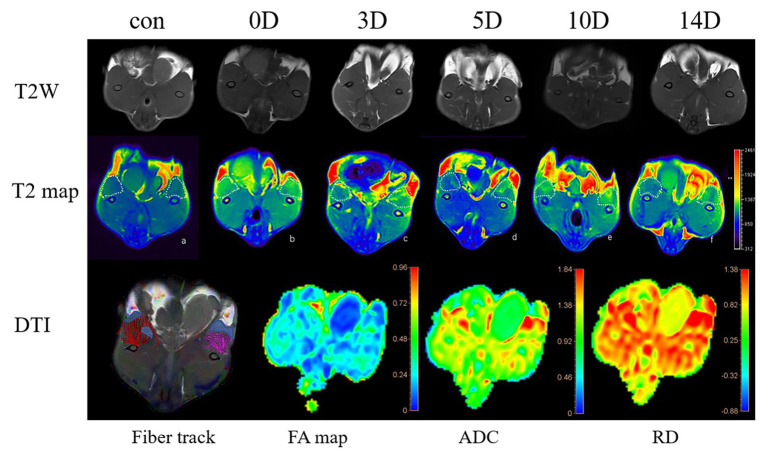
T2WI, T2map axial sequence images in the (a-f) control group and frostbite group (0, 3, 5, 10, 14 days). The muscles in the ROI were manually drawn on the T2 map: the muscle in the control ROI is blue. The color of the ROI area changed significantly after frostbite. The diffusion tensor imaging (DTI) sequence: the schematic diagram of the fiber track of the DTI and the corresponding fractional anisotropy (FA) map, mean diffusivity (MD) map, and RD map. The area with fewer muscle fibers in the fiber track diagram is consistent with the high-signal area in the MD picture.